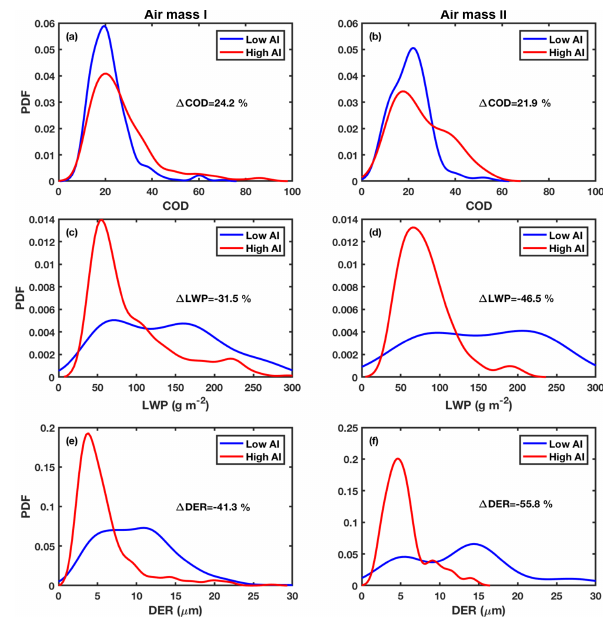
Figure 9. From top to bottom, probability distribution functions (PDFs) of cloud optical depth (COD), liquid water path (LWP), and cloud droplet effective radius (DER) at low (L, in blue) and high (H, in red) scattering aerosol index (AI) levels for the cluster I air mass ( a , c , e ) and the cluster II air mass ( b , d , f ). The mean percentage difference in COD, LWP, and DER between high and low scattering AI levels (calculated as [(H–L/L)]*100%) is given in each